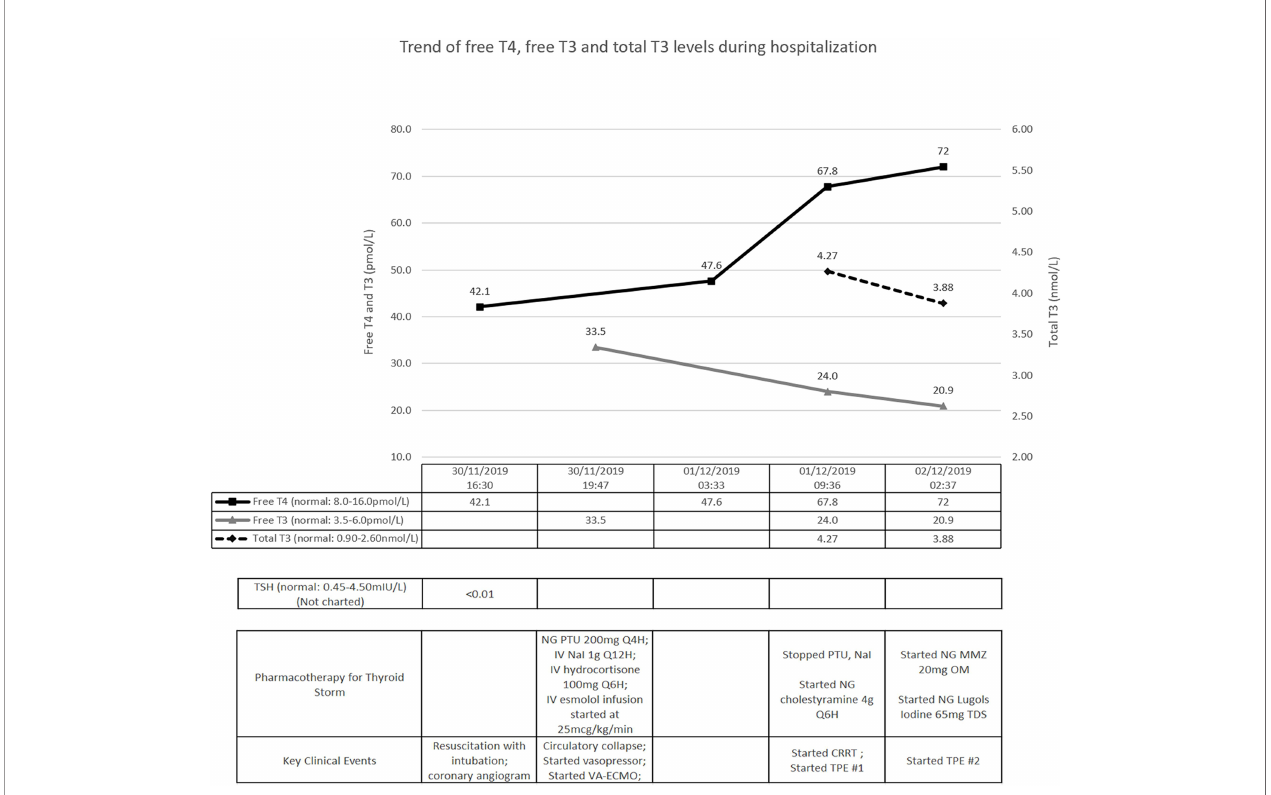
FIGURE 1 | Timeline of key clinical events. T4, thyroxine; T3, tri-iodothyronine; TSH, thyroid-stimulating hormone; NG, nasogastric; IV, intravenous; PTU, propylthiouracil; NaI, sodium iodide; VA-ECMO, veno-arterial extra-corporeal membrane oxygenation; CRRT, continuous renal replacement therapy; TPE, therapeutic plasma exchange; MMZ,